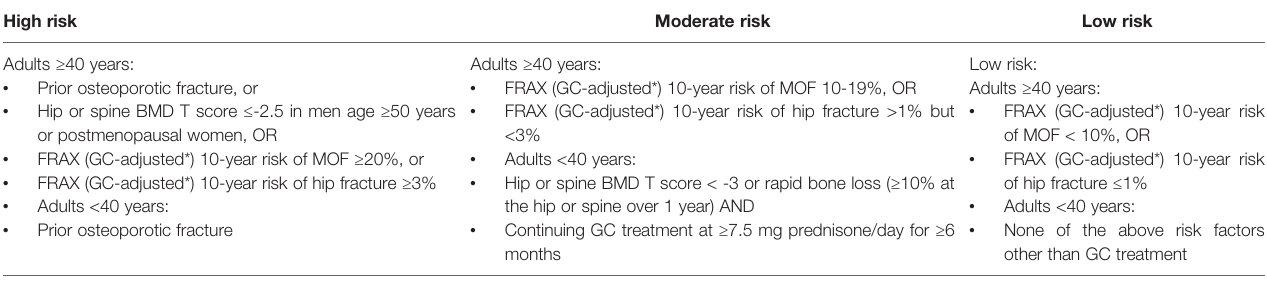
MOF, major osteoporotic fracture (clinical vertebral, hip, wrist, or humerus). *If GC treatment >7.5 mg/day prednisone or equivalent, increase major osteoporotic risk by 1.15 (15%) and hip fracture risk by 1.2